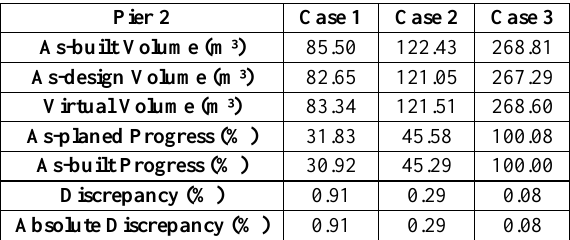
Figure 9 . Poisson surface reconstruction results and their quality heat map for 3 cases of Pier 1.